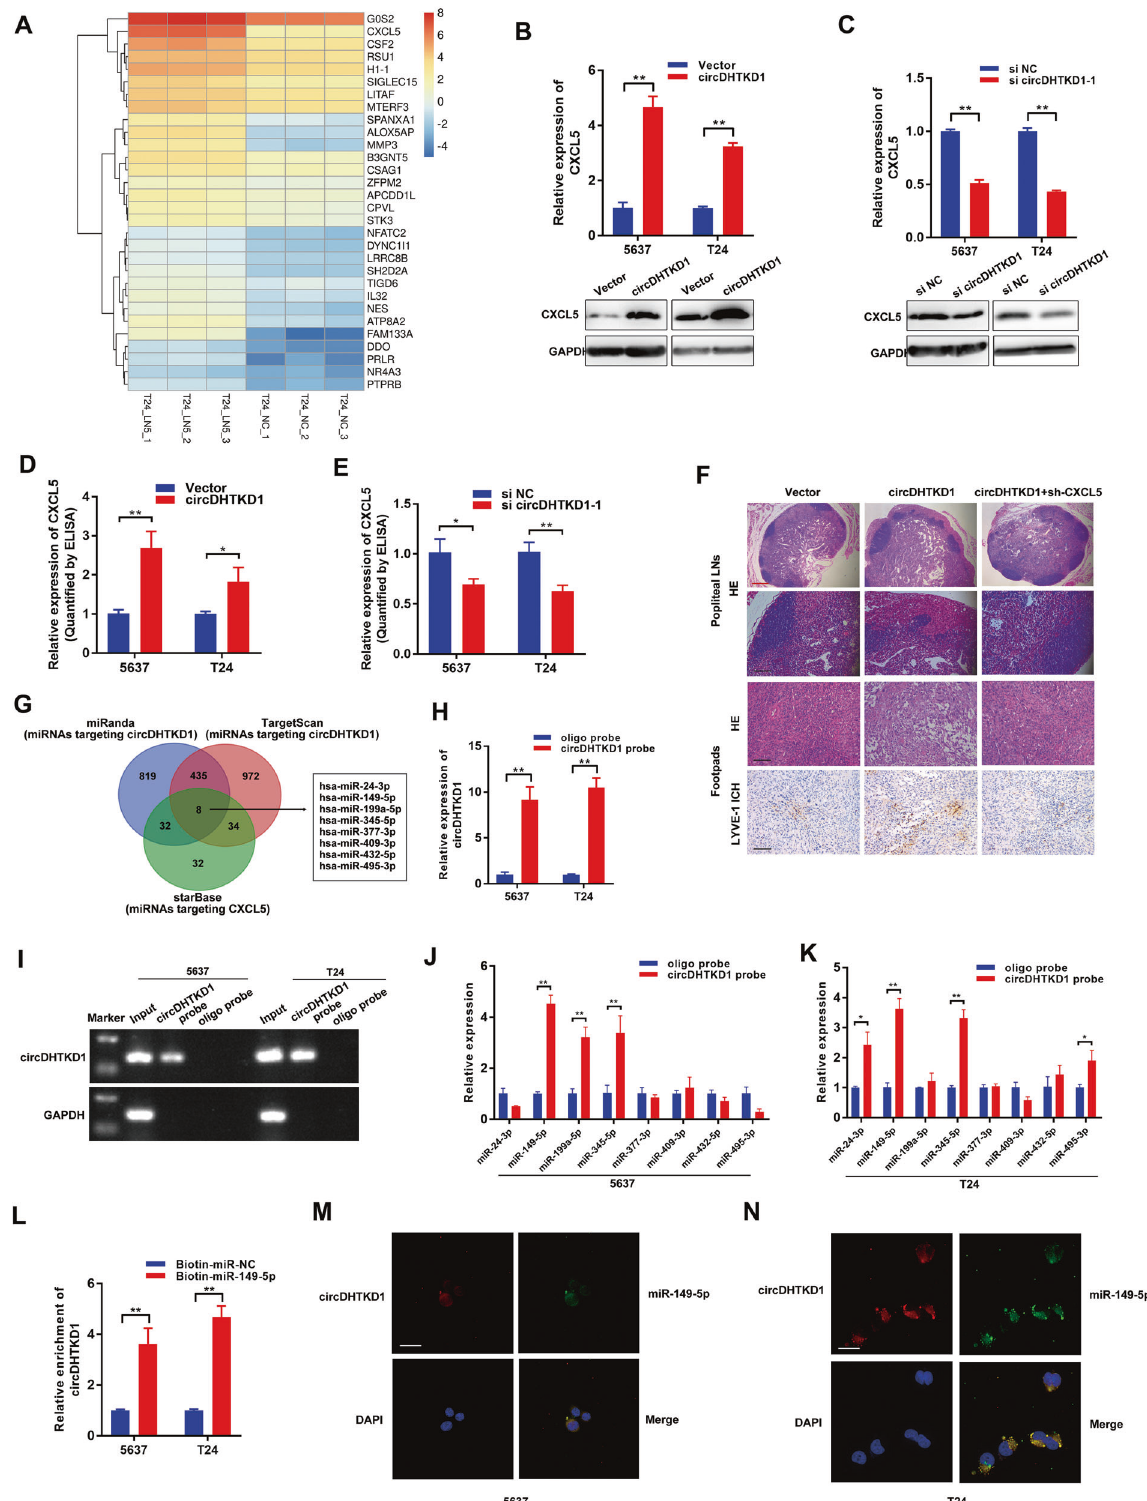
The level of CXCL5 in LN metastasis was signi fi cantly higher than that in primary head and neck squamous cell carcinoma [30]. CXCL5 also plays a key role in lymphangiogenesis in melanoma, which can be inhibited by blocking the CXCR2 receptor [21]. At present, the speci fi c regulatory mechanism of CXCL5 in LN